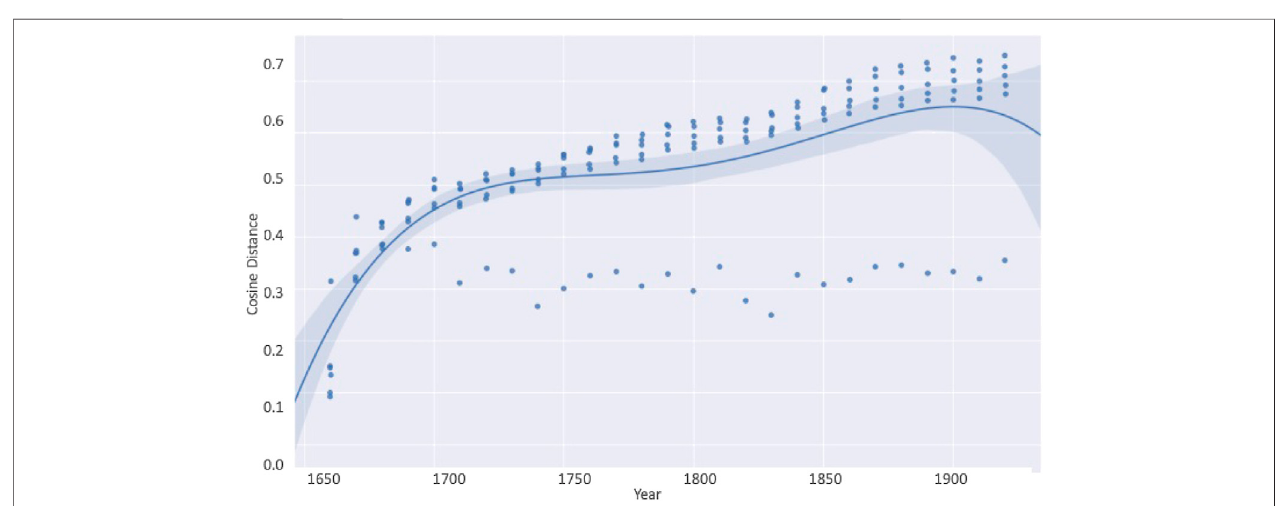
FIGURE 2 | Average cosine distances of words between randomly chosen groups of words for lexical words (upper points) and function words (lower points) .